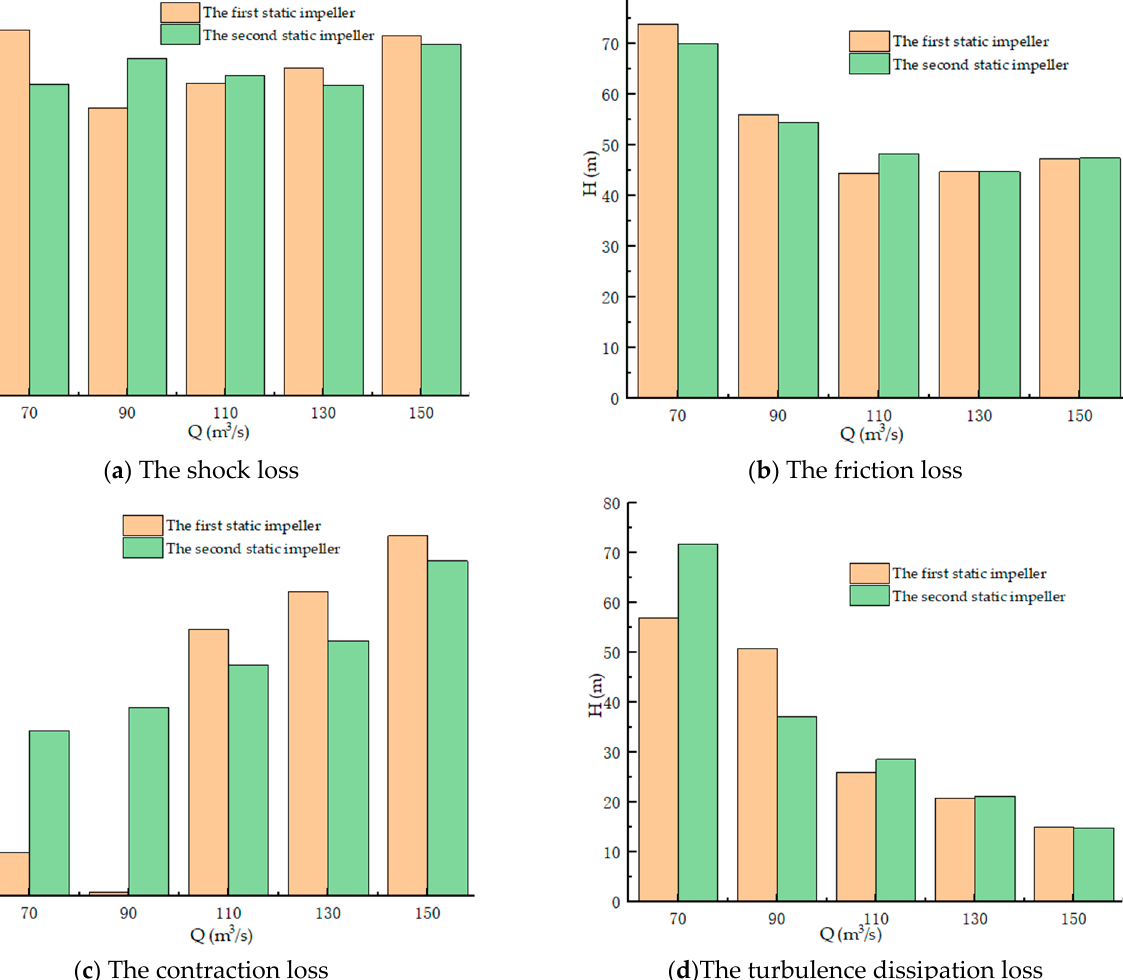
Figure 22. (a – d) Variation law of hydraulic loss in static impeller of multiphase pump. Figure 22. ( a – d ) Variation law of hydraulic loss in static impeller of multiphase